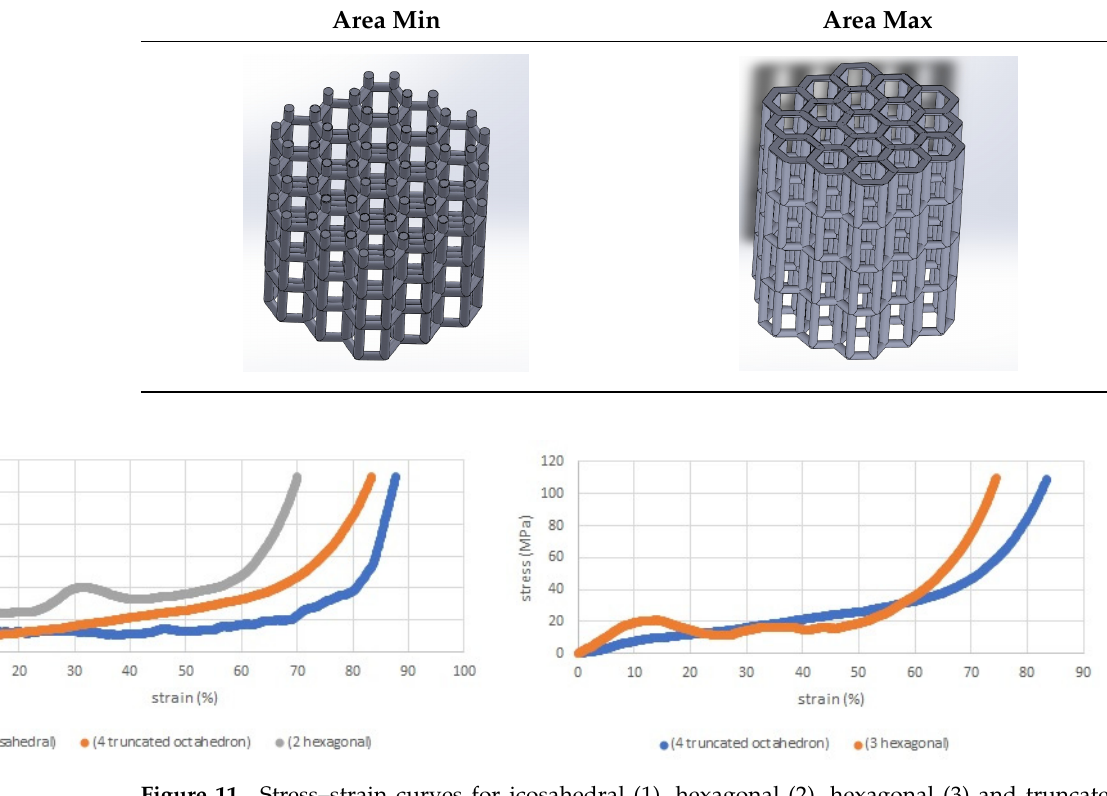
Figure 11. Stress–strain curves for icosahedral (1), hexagonal (2), hexagonal (3) and truncated octahedron (4).